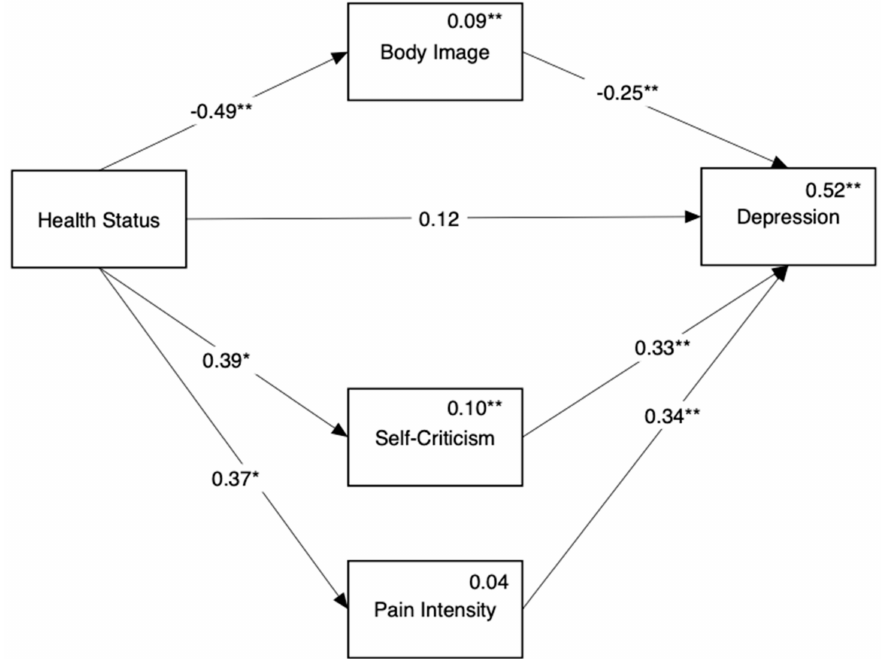
Figure 4. Mediation of the link between disease status (endometriosis only or endometriosis ACI) and depression by body image, self-criticism, and pain intensity. Reference group for comparison is the endometriosis only group. Numbers above the direct links are standardized regression coefficients. Numbers above variable names are multiple squared correlations. Age was included in the model as a covariate but is not presented in this figure. * p < 0.05, ** p <